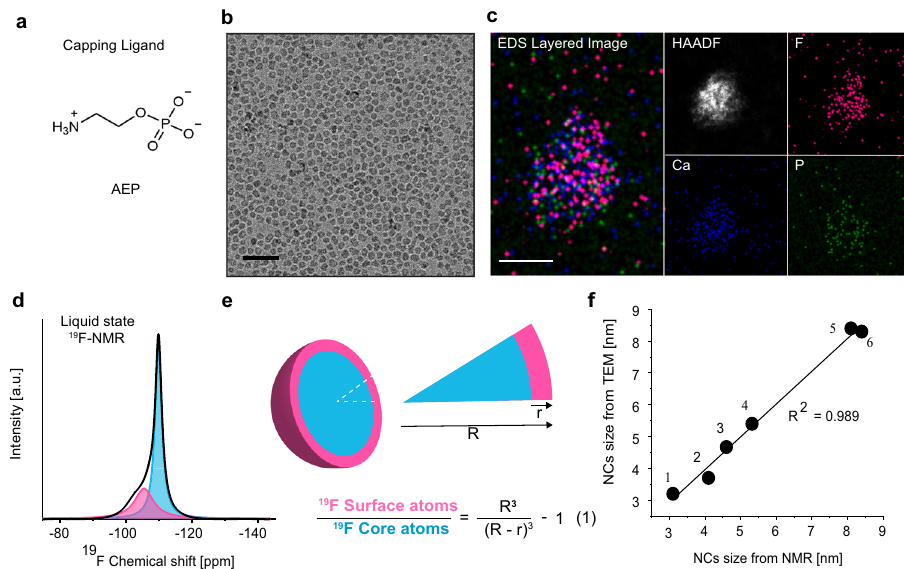
Fig. 1 Characterization of AEP-CaF 2 NCs. a Molecular structure of an AEP ligand at pH 7. b Cryo-TEM AEP-CaF 2 NCs (scale bar 20 nm). c STEM-EDS elemental maps of an agglomerate of dried AEP-CaF 2 NCs (scale bar 10 nm). Shown are a combined map of the NCs elements, a high-angle annular dark- fi eld (HAADF) image (white) and elemental maps of each element, i.e., F (pink), Ca (blue), and P (green). ( d ) Liquid-state, high-resolution 19 F-NMR spectrum of water-dispersed AEP-CaF 2 NCs and its deconvoluted signals, attributed to 19 F atoms at the surface of the NCs (-105 ppm, pink) and in the NC core ( − 109 ppm, light blue). e Schematic illustration of the CaF 2 NC with its surface (pink) and core atoms (light blue) and the equation (1) used to evaluate the size of NCs from the 19 F-NMR spectrum (Eq. (1) and Supplementary Note 1). f Correlation between the sizes measured with NMR and TEM of various CaF 2 and SrF 2 NCs bearing different ligands (AEP, Citrate (Cit), Oleic Acid (OA) and Polyethylene Glycol (PEG)); (1) Cit-CaF 2 (Fig. 5b) (2) AEP- CaF 2 (3) AEP-SrF 2 (Fig. 3) (4) OA-SrF 2 (Supplementary Fig. 3b) (5) PEG-CaF 2 (Supplementary Fig. 3a) (6) OA-CaF 2 (Supplementary Fig.